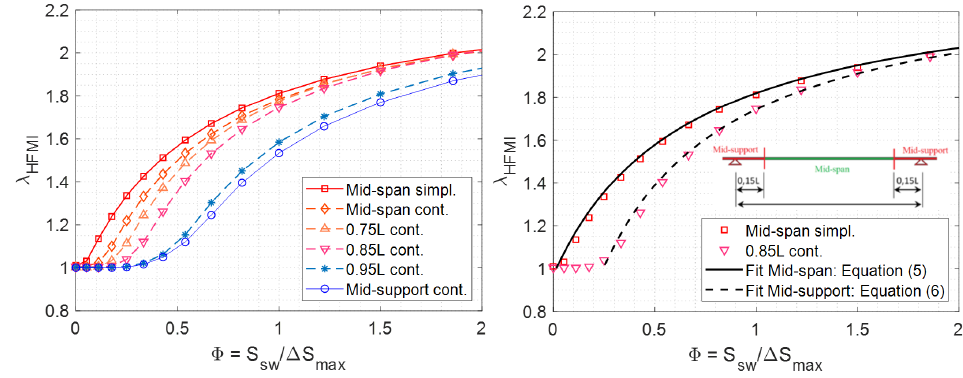
Figure 3. ( Left ): Extracted highest Φ – λ HFMI curves of different positions along the span length; ( Right ): The proposed Φ – λ HFMI curves for design, adapted from